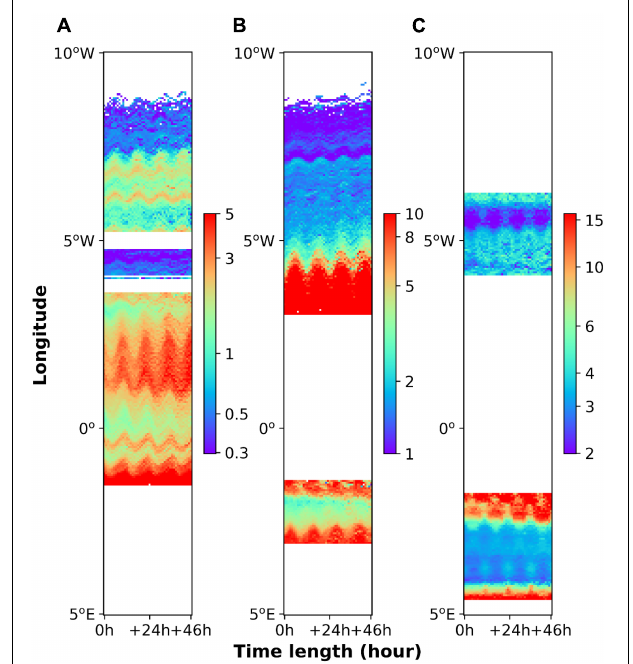
FIGURE 6 | Map showing the distribution of predicted Chl at 15th September 8 p.m. (first predicted image) overlaid with lines of latitudes at 50 ◦ N, 51.3 ◦ N, and 52.5 ◦ N.